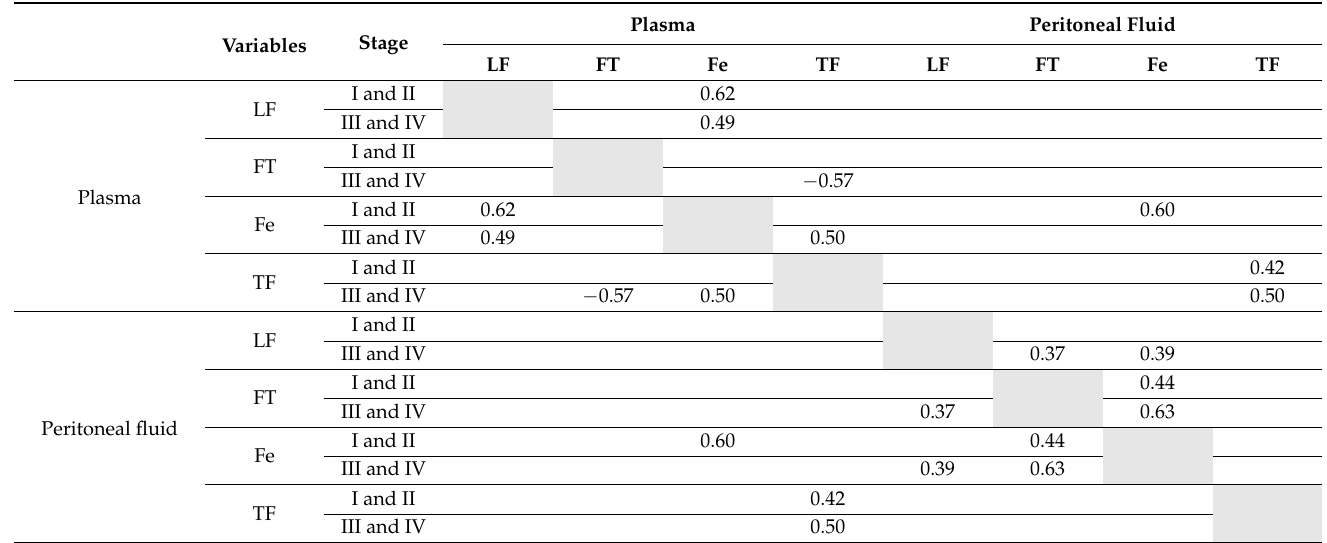
Table 5. Spearman’s rank correlations for lactoferrin (LF), ferritin (FT), iron (Fe) and transferrin (TF) for plasma and peritoneal fluid in group with endometriosis by mild (stages I and II, n = 25) and severe (stages III and IV, n = 32), only statistically significant coefficients presented.